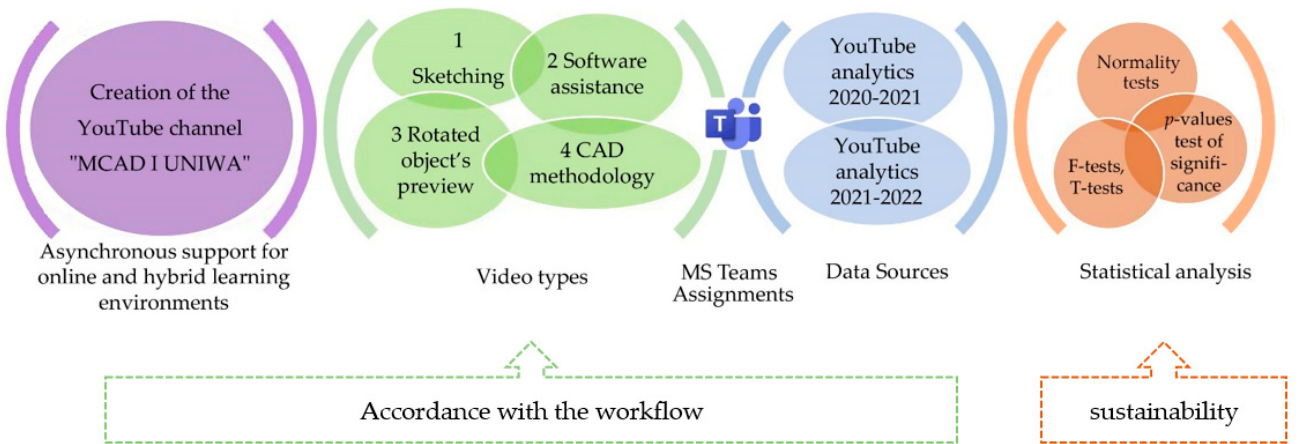
Figure 1. Flow chart illustrating the data mining and processing methodology applied.